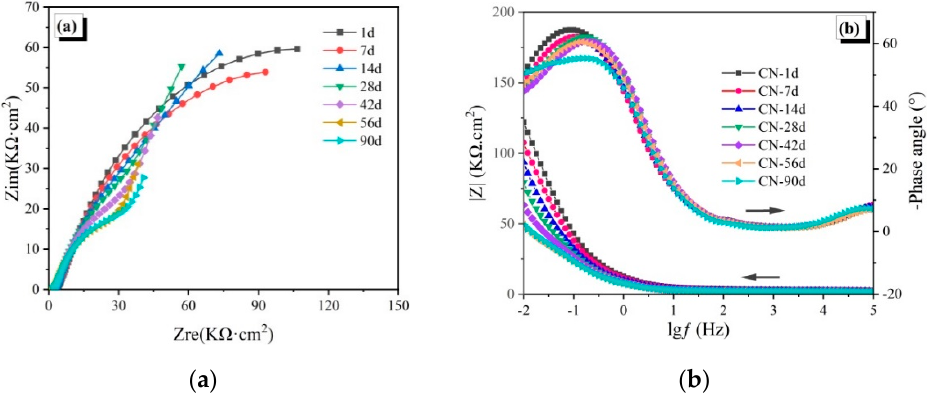
Figure 6. Electrochemical impedance spectroscopy of the CN-10 specimens: ( a ) Nyquist curves, ( b ) Bode